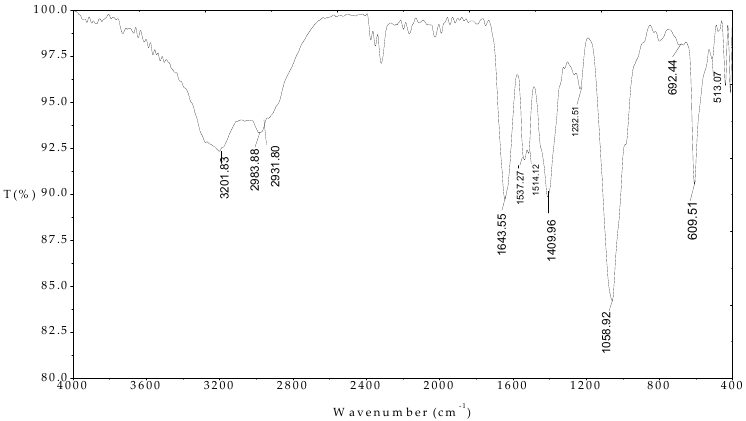
Figure 4. FTIR spectrum of Moringa (MO) seeds protein in the wave number range 400–4000 cm − 1 .